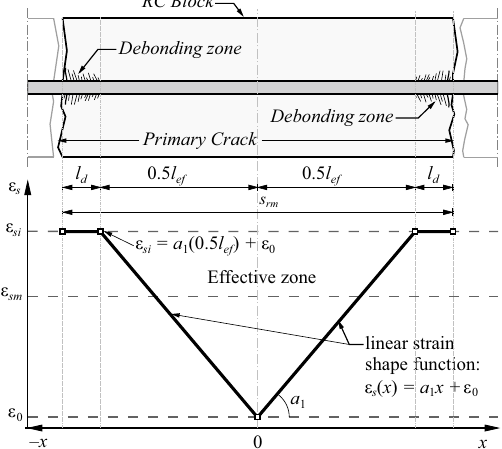
linear strain a 1 ε 0 Figure 1. Reinforcement strains represented by the debonding zones and effective zone